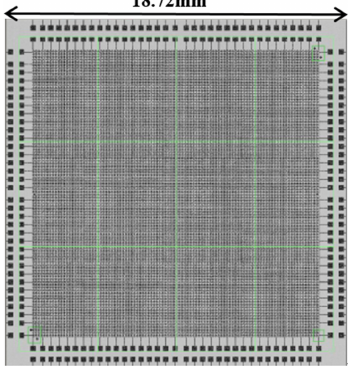
Figure 8. Morphology of a single die scanned by AOI.